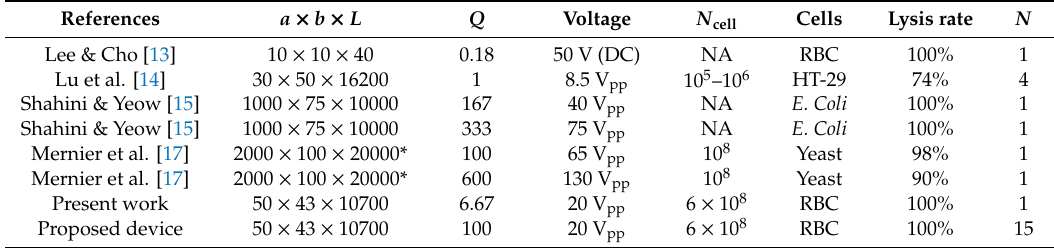
Table 2. Comparisons of throughputs among several